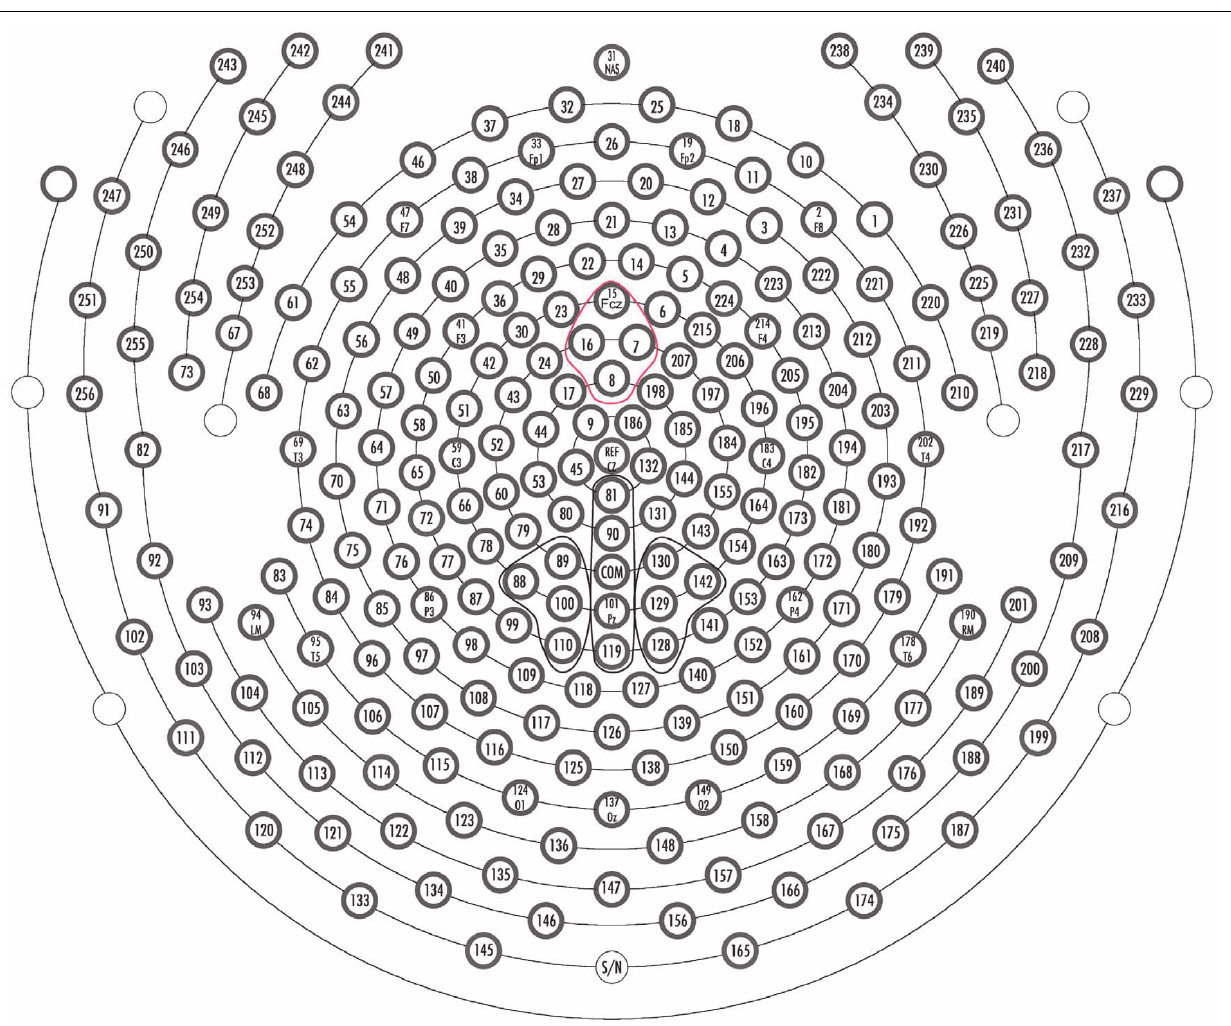
FIGURE 4 | Sensor layout for 256-channel Hydrocel Geodesic Sensor Net. Orientation of layout is top looking down with the nose at the top of the page. Channel groups used to quantify ERP components: Red: MFN, Black: